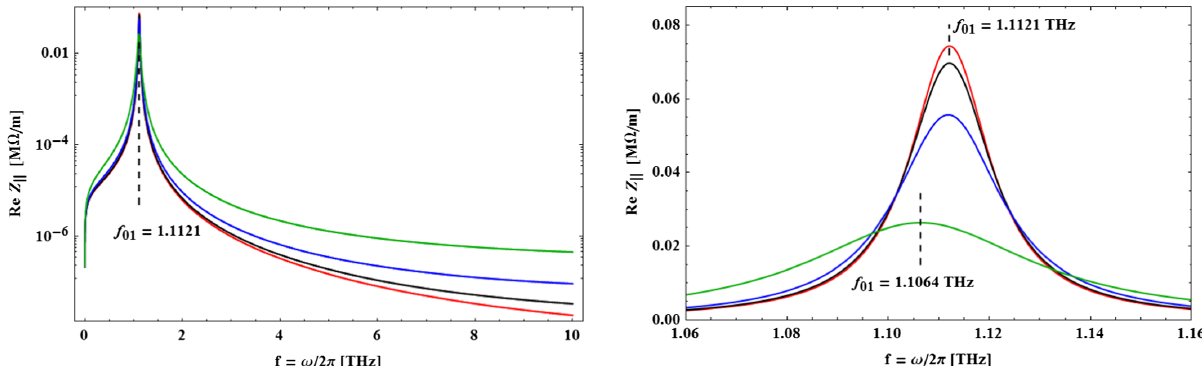
FIG. 10. The longitudinal monopole impedance of a two-layer metal-dielectric structure for different values of ε 00 1 : ε 00 1 ¼ 0 (red line), 0.1 (black line), 0.5 (blue line), and 3 (green line). Left: Wide terahertz range of impedance distribution. Right: The resonance